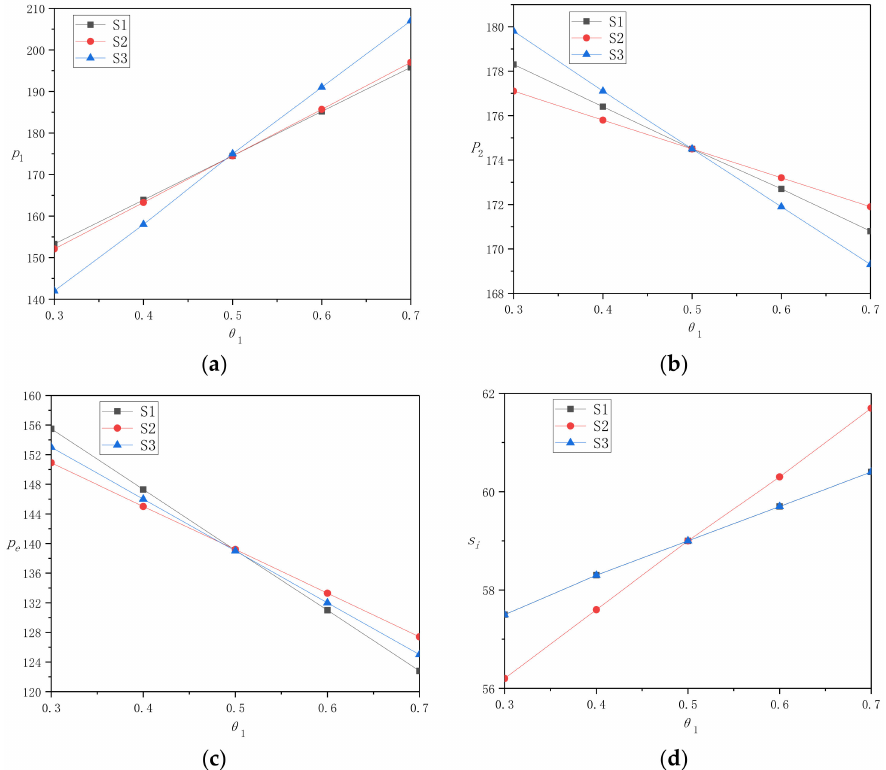
Figure 2. The change of decisions under three strategies as θ 1 increases: ( a ) p 1 , ( b ) p 2 , ( c ) p e , ( d ) s i .